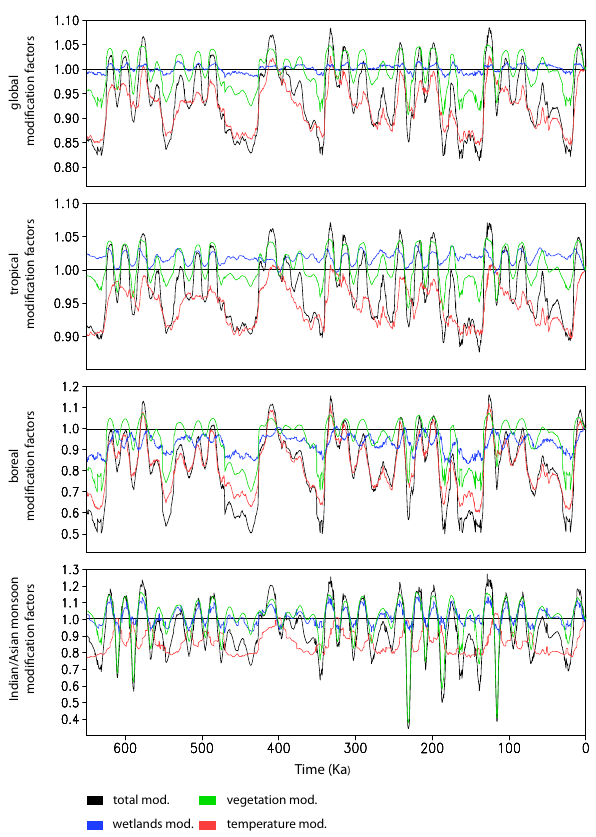
Fig. 9. Time series of the modification factors, as defined in Sect. 3.2, for the entire globe and for the tropical, boreal and In- dian/Asian monsoon areas